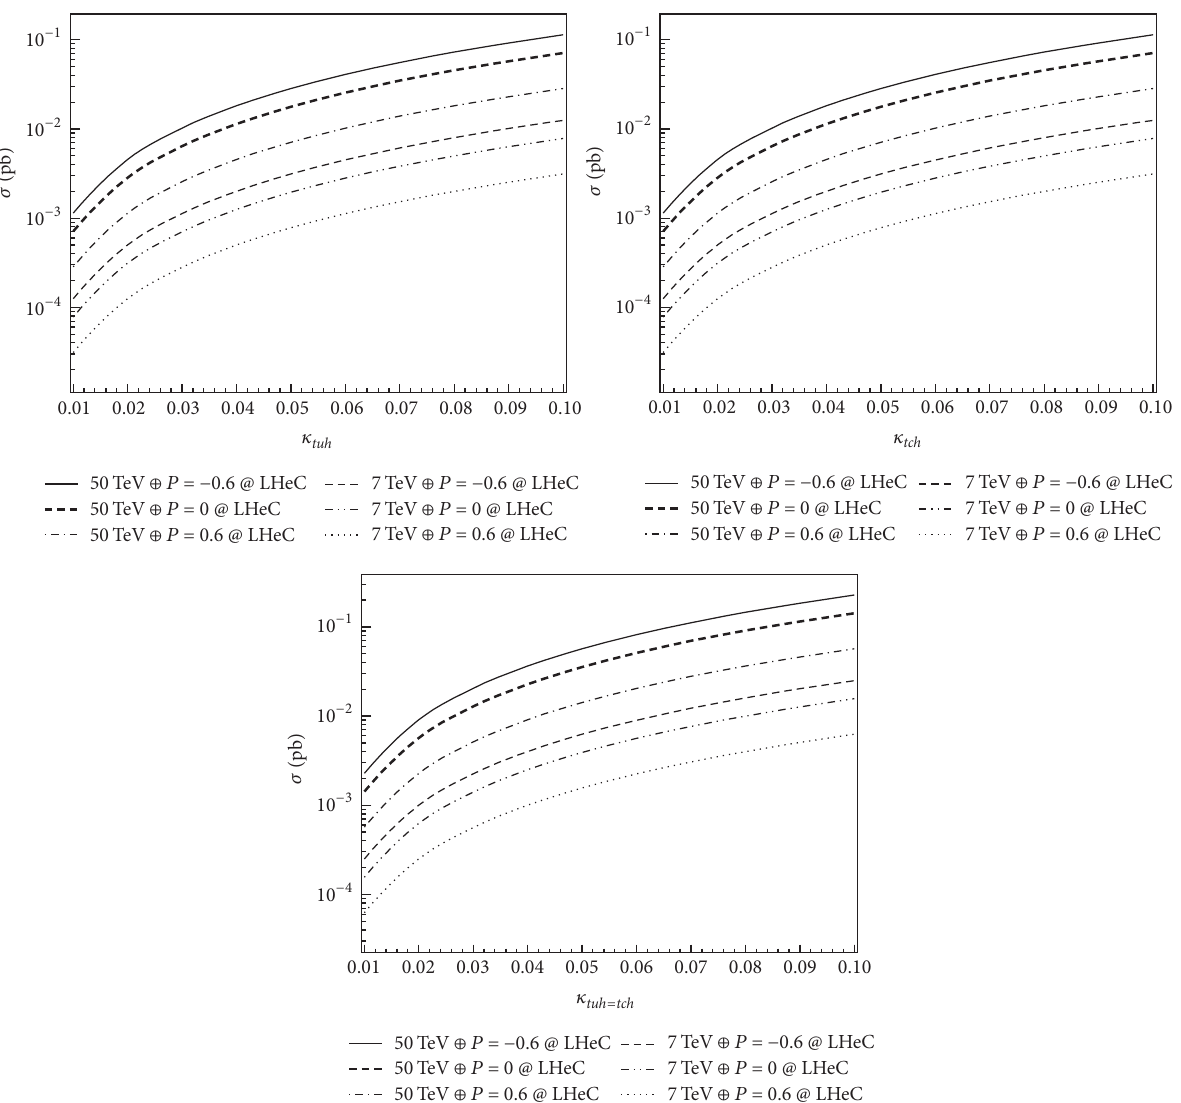
Figure 2: The cross sections 𝜎 𝑡𝑞ℎ on the top-Higgs FCNC couplings 𝜅 𝑡𝑞ℎ at the 7 (50)TeV and 60 GeV LHeC with 𝑒 -beam polarization 𝑝 = 0, ±0.6 𝑒